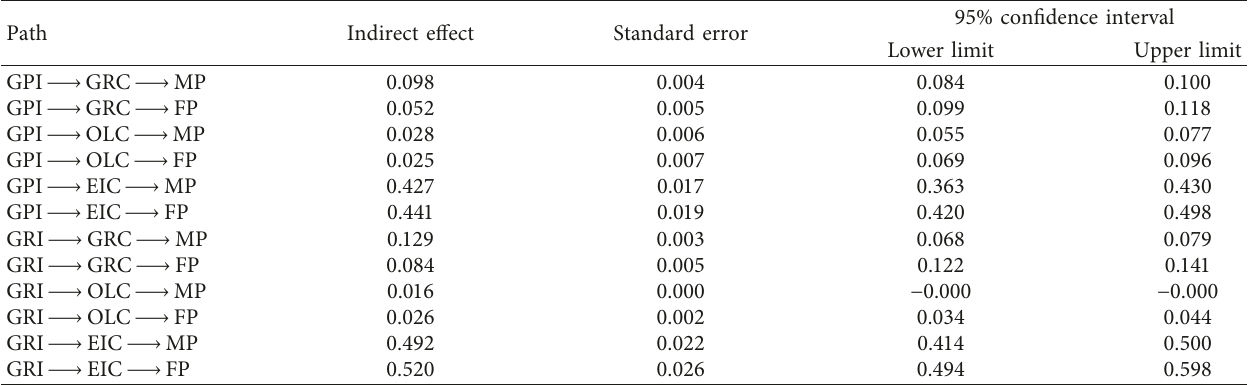
Table 12: Bootstrap